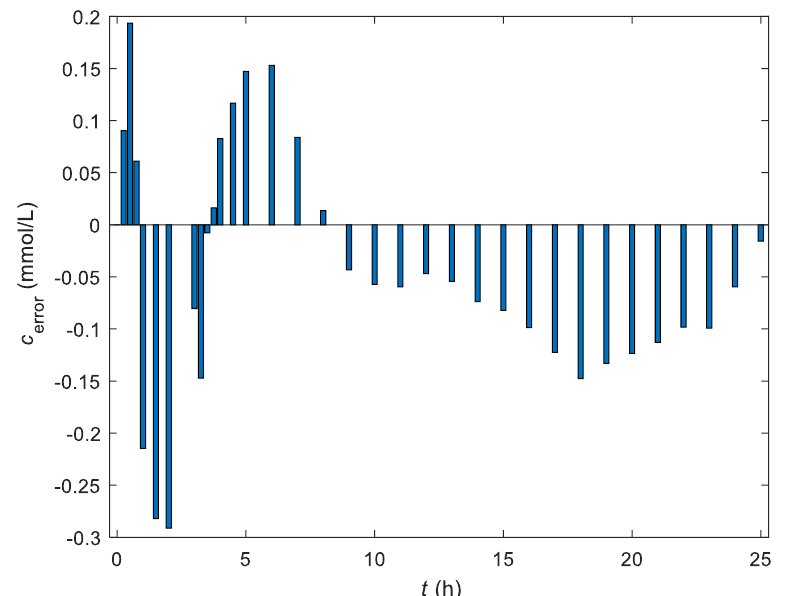
Figure 6. The deviation between the response of the dissolved CO 2 concentration of the identified complete model and the response of the dissolved CO 2 concentration of the laboratory batch bioreactor at different moments of the fermentation process. Table 5. Quantitative assessment of the accuracy of the identified model (deviation between simu- lated and measured valued).